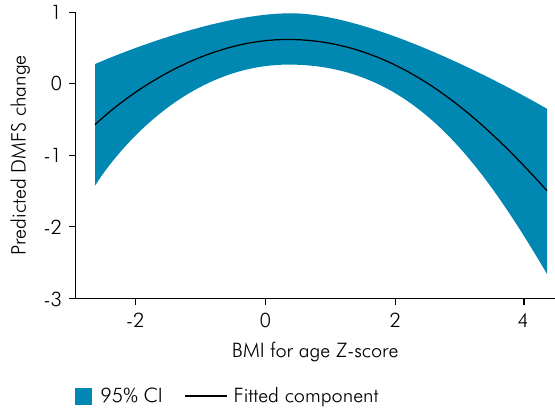
Figure 2. Predicted Δ DMFS according to BMI-for-age Z-score adjusted for sex, socioeconomic status, school, soft drinks consumption and brushing frequency.